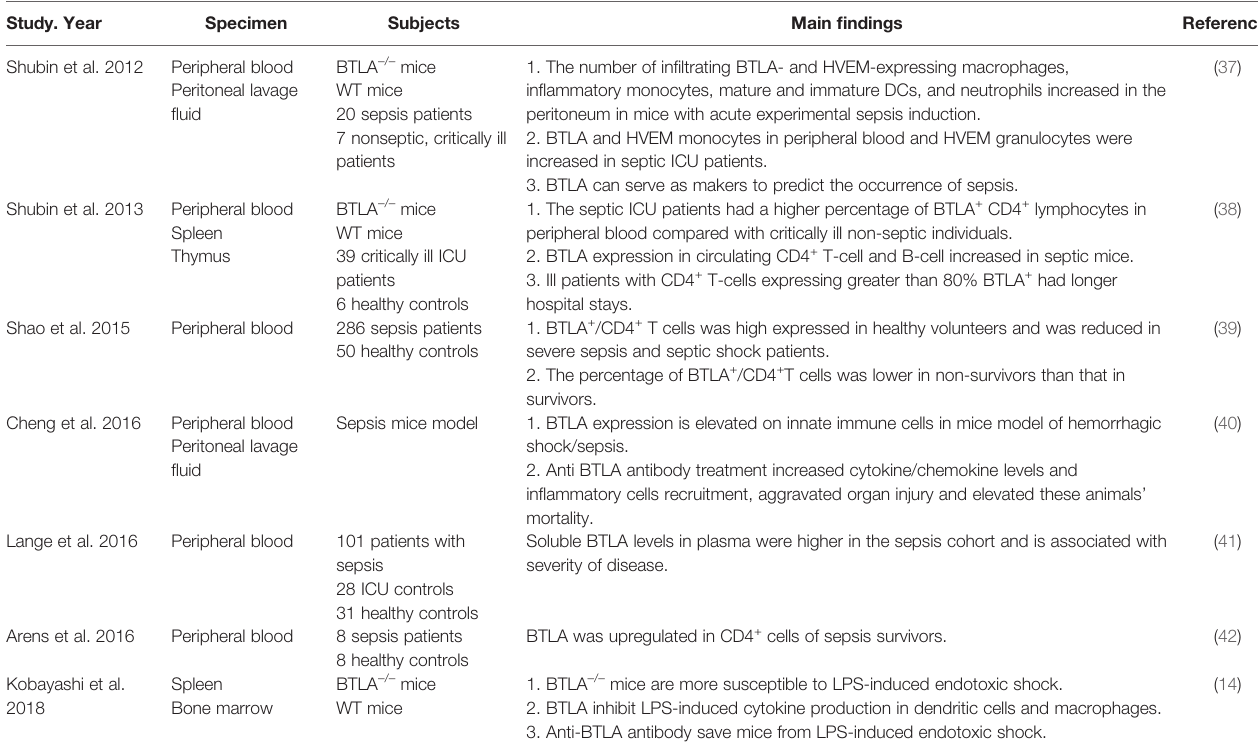
TABLE 3 | The function of BTLA in